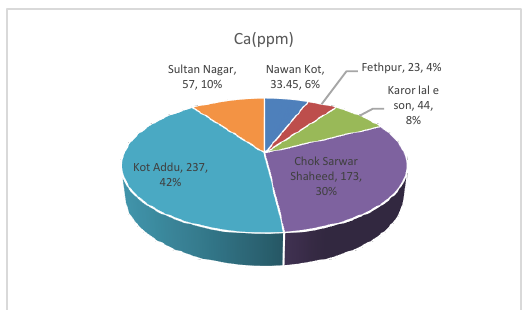
Figure 14: Sodium concentration of different sites of Layyah and Muzaffargarh.